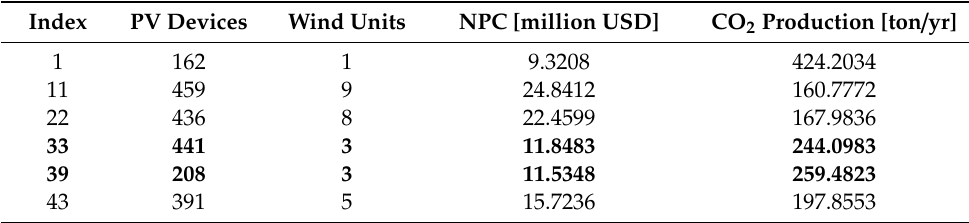
Table 6. Feasible values to consider as an option, obtained from Table